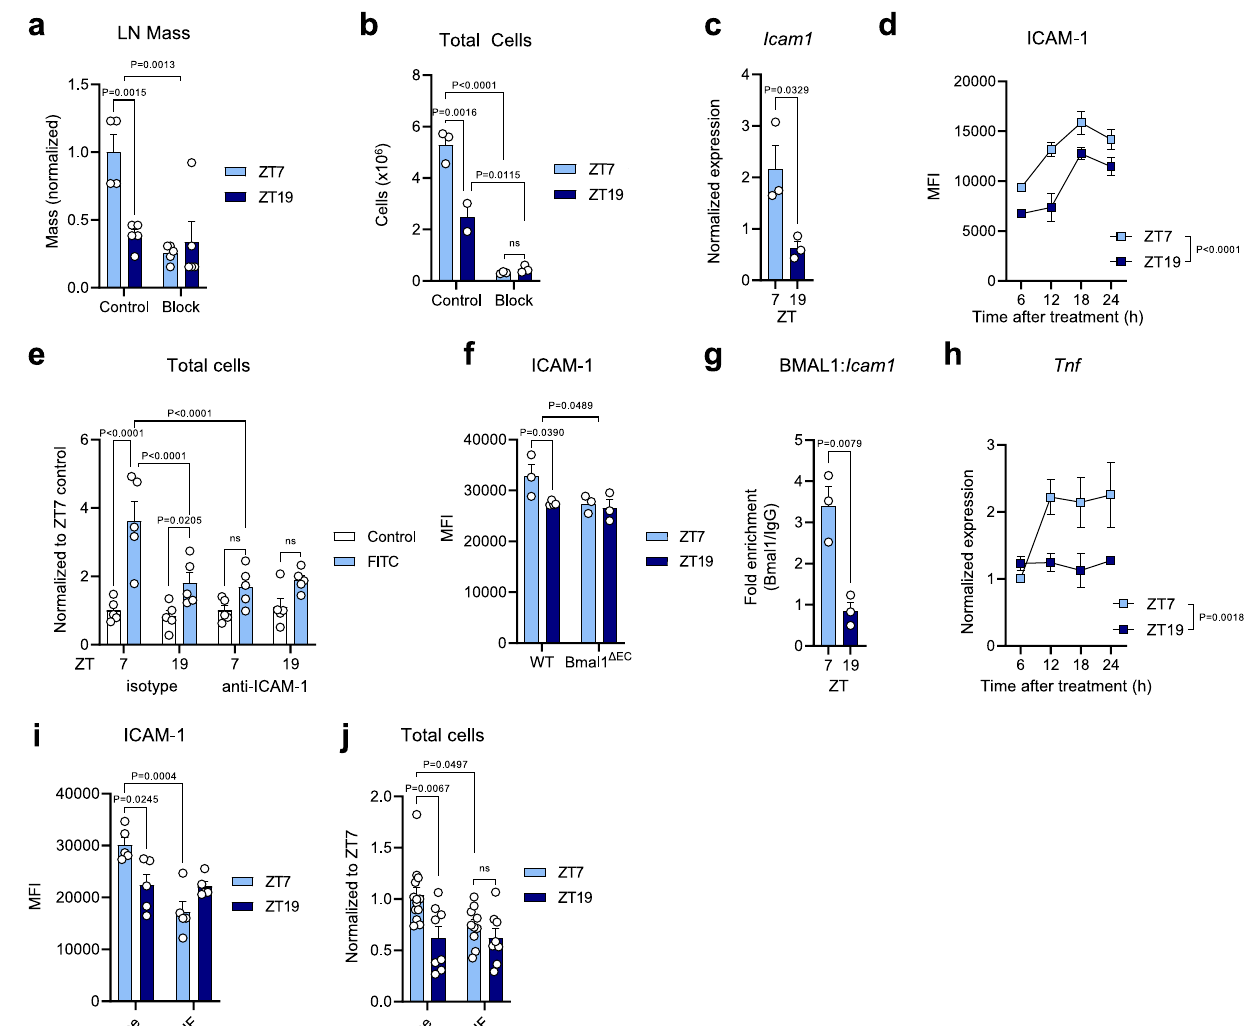
Fig.2|RhythmicDCtraf fi ckinginduceslymphnodehoming.a Popliteallymph node (LN) mass 24h following subcutaneous injection of 1×10 6 bone marrow- derived dendritic cells (BMDCs), with or without prior treatment with integrin- blocking antibodies, normalized to average ZT7 mass; n =4 – 5 mice, two-way ANOVA with Sidak ’ s post test. b Popliteal LN cellularity 48h following sub- cutaneous injection of 1×10 6 BMDCs, with and without prior treatment with integrin-blocking antibodies; n =2 – 3 mice, two-way ANOVA with Sidak ’ s post test. c Icam1 mRNA expression inparotidLN12h after topicalapplicationof FITC; n =3 mice, unpaired two-sided Student ’ s t test. d Time course of ICAM-1 protein levels on high endothelial venules (HEVs) of parotid LNs by quantitative imaging after topical FITC application; n =3 mice, two-way ANOVA with Sidak ’ s post test. e LN cellularity 48h aftertopicalFITCapplication, with or withoutprior treatment with anti-ICAM1 antibody; n =5 mice, two-way ANOVA with Fisher ’ s post test. f ICAM-1